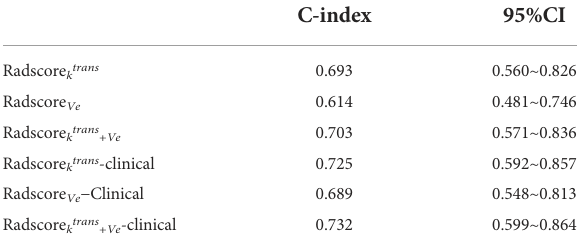
TABLE 2 C-indexes of the Radscore and Radscore-based models.